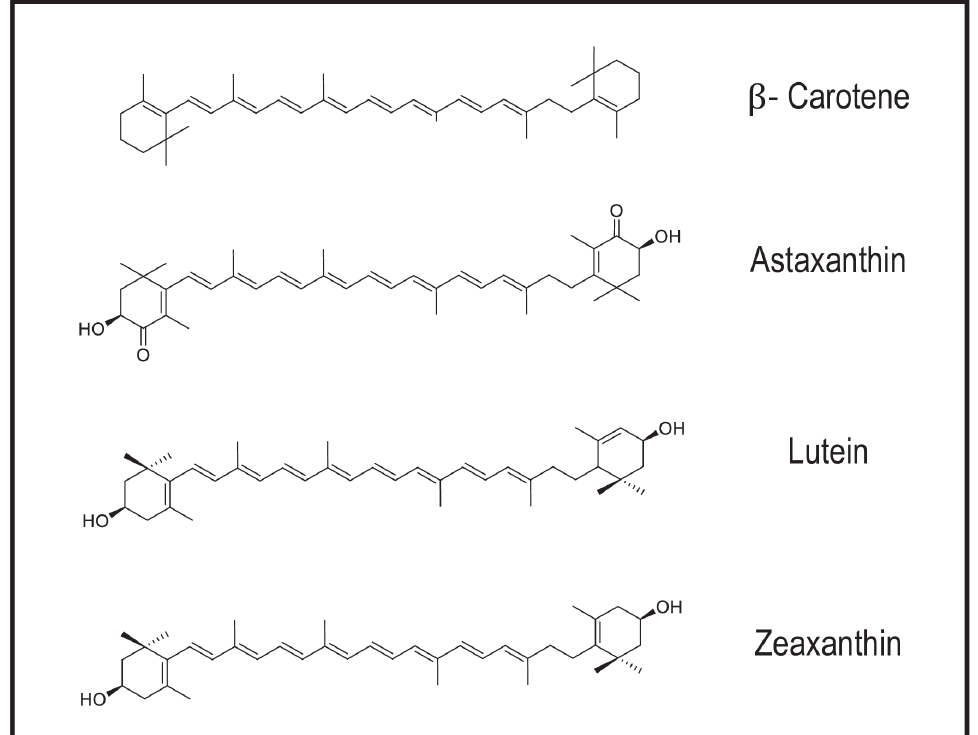
FIGURE 5 - Chemical structure of some common